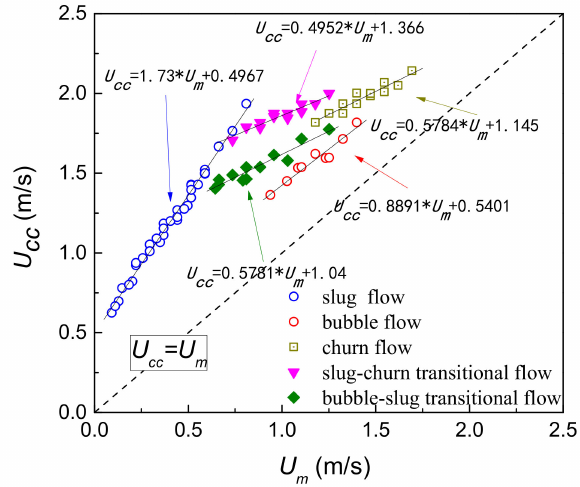
Figure 12. Relationships between mixture velocity U m and cross-correlation velocity U cc